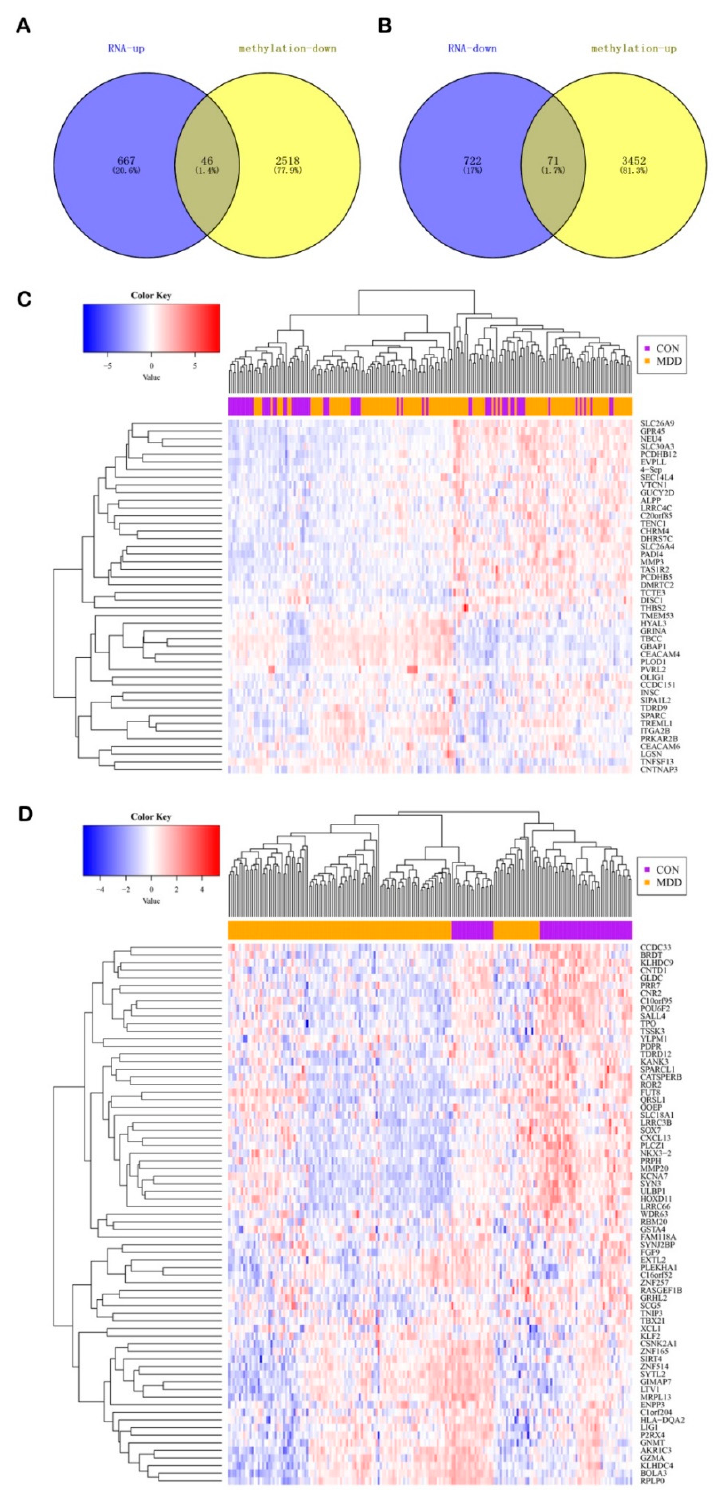
Figure 5. Identification of the hypo-up genes and hyper-down genes. Venn diagram of ( A ) the hypo-up genes and ( B ) the hyper-down genes. Heatmap of ( C ) the hypo-up genes and ( D ) the hyper-down genes between the MDD patients and healthy controls.